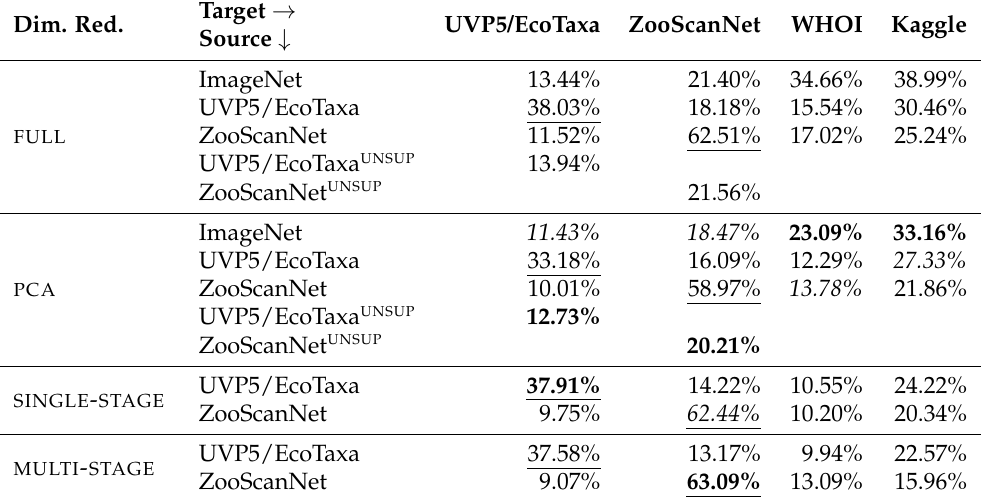
Table 1. Quality of supervised and unsupervised image representations measured as the test NCC-F1 on each target dataset for each condition and source dataset, respectively. The first rows show the test scores for full feature dimensionality for reference, the following rows show the results for different methods of dimensionality reduction to d = 32. All models were trained supervised, unless unsupervised training is indicated by UNSUP . Conditions where labeled target domain data were used for training (non-blind) are underlined. The best blind and non-blind result is bold, respectively, the second best is